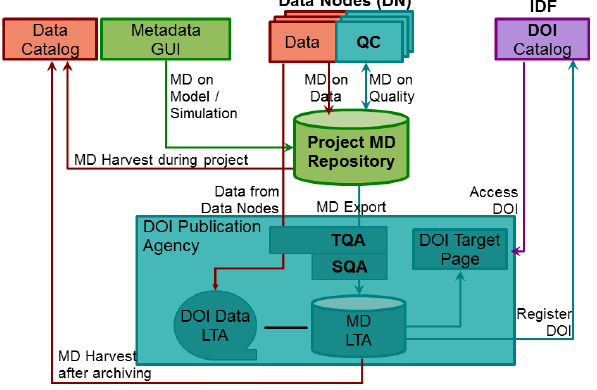
Fig. 2. Distributed quality control in a federated data infrastructure